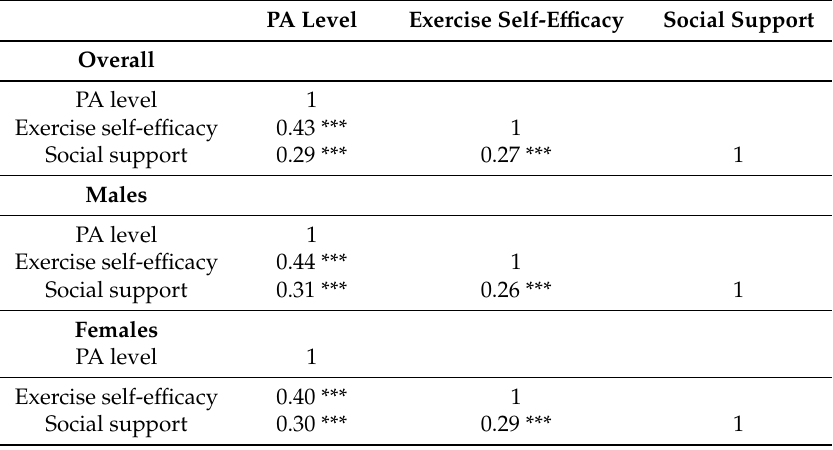
Table 2. Associations among PA level, social support and exercise self-e ffi cacy.